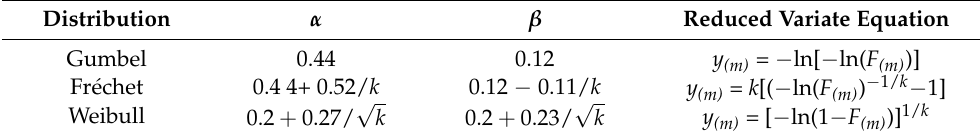
Table 1. Coefficient values and reduced variate for extreme value distributions. Distribution α β Reduced Variate Equation Gumbel 0.44